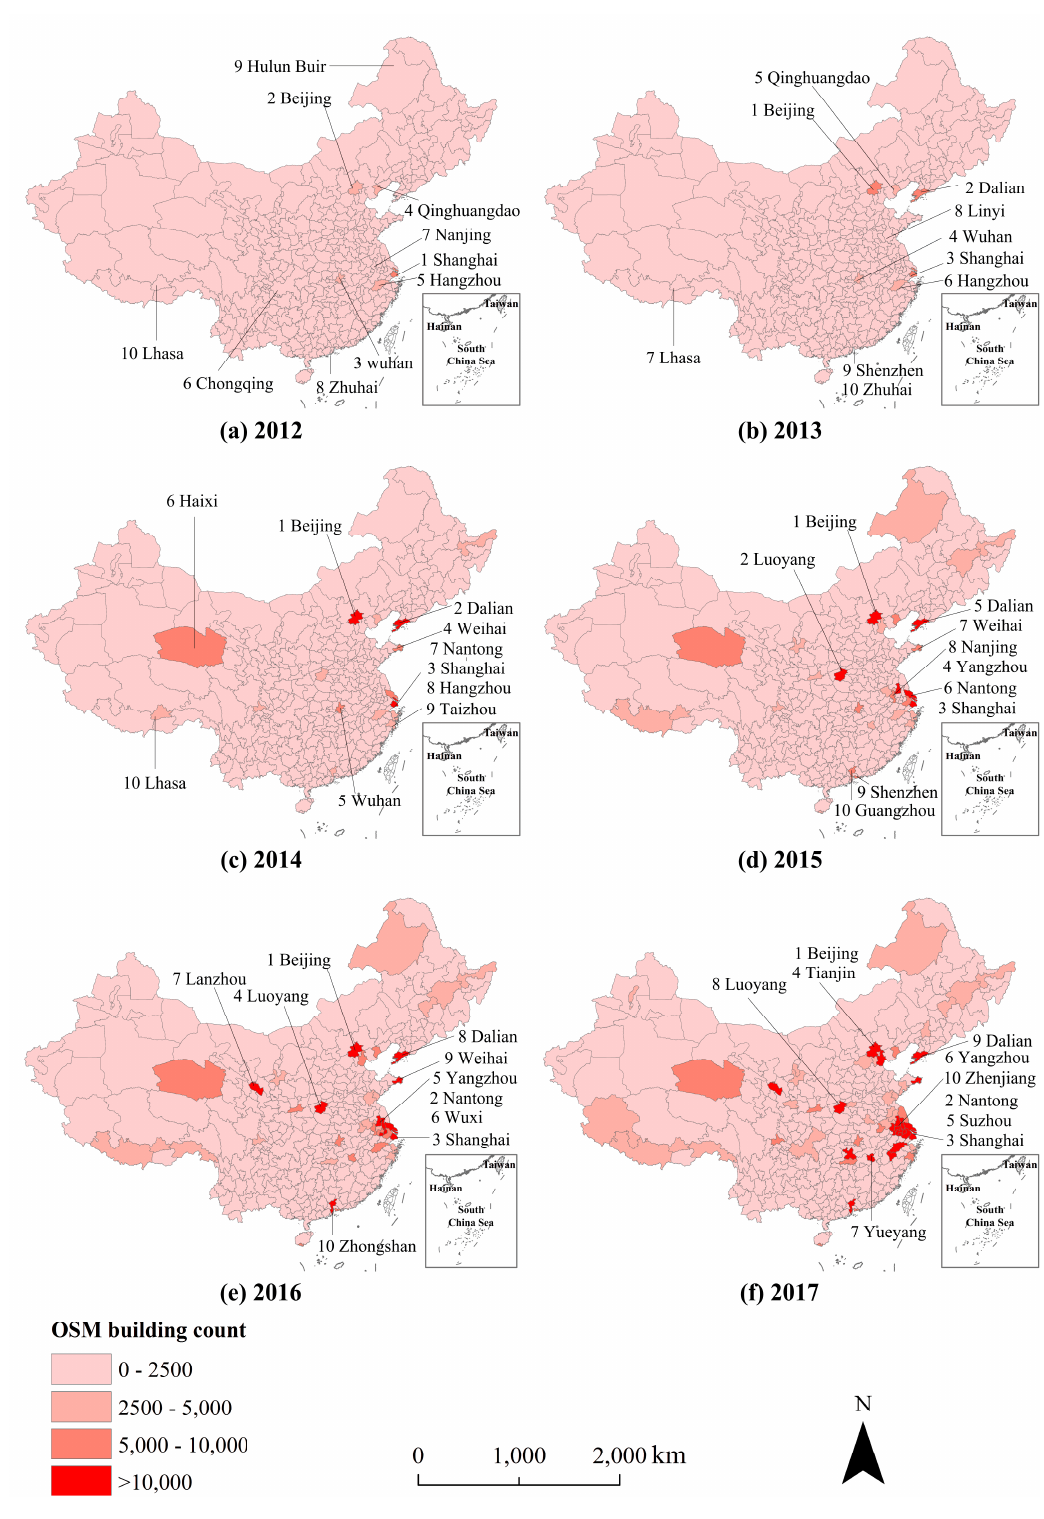
Figure 4. Number distribution of OSM building data for prefecture-level divisions in China, from 2012 to 2017 ( a – f ).